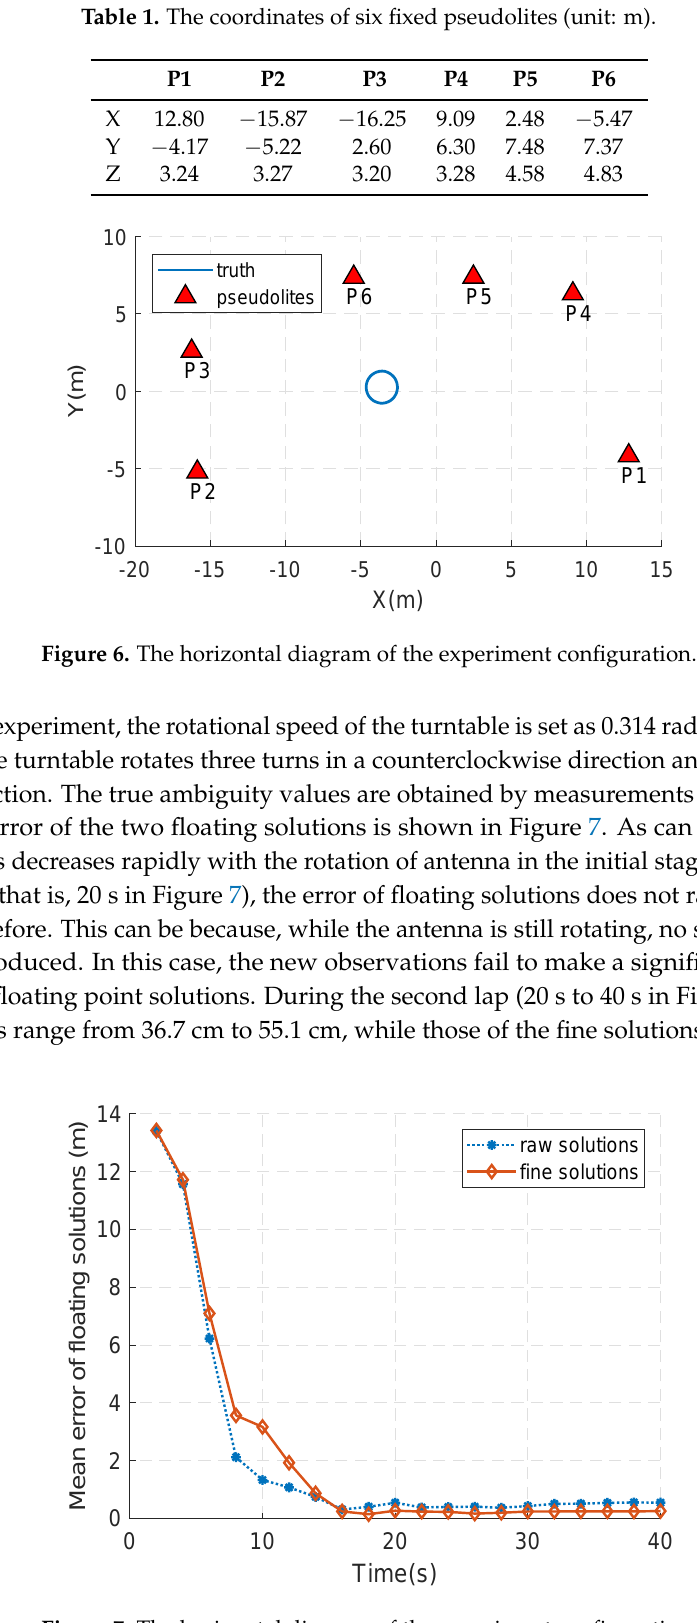
Figure 7. The horizontal diagram of the experiment